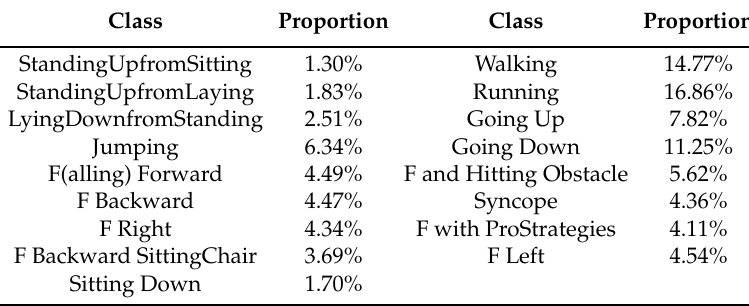
Table 5. Classes and proportions for the UniMiB-SHAR